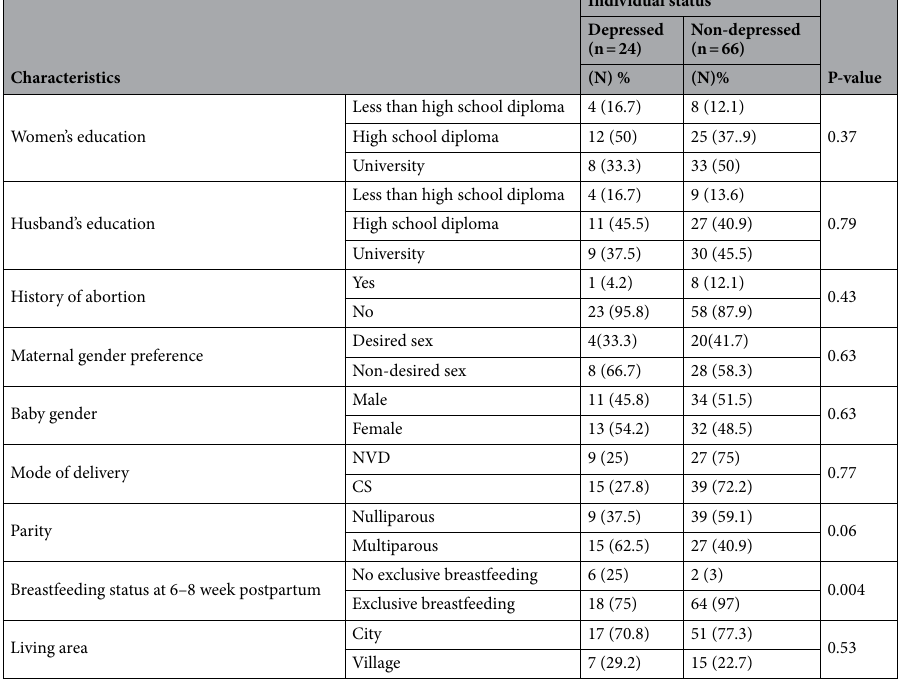
Table 1. Demographic and clinical characteristics of the subjects (n =